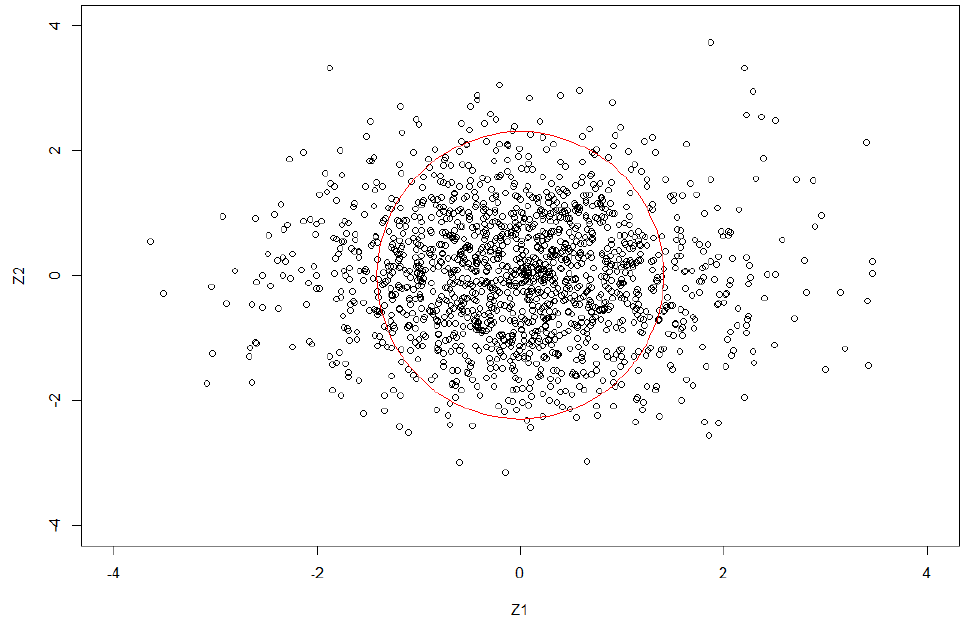
Figure 1. Inferential on the signals based on